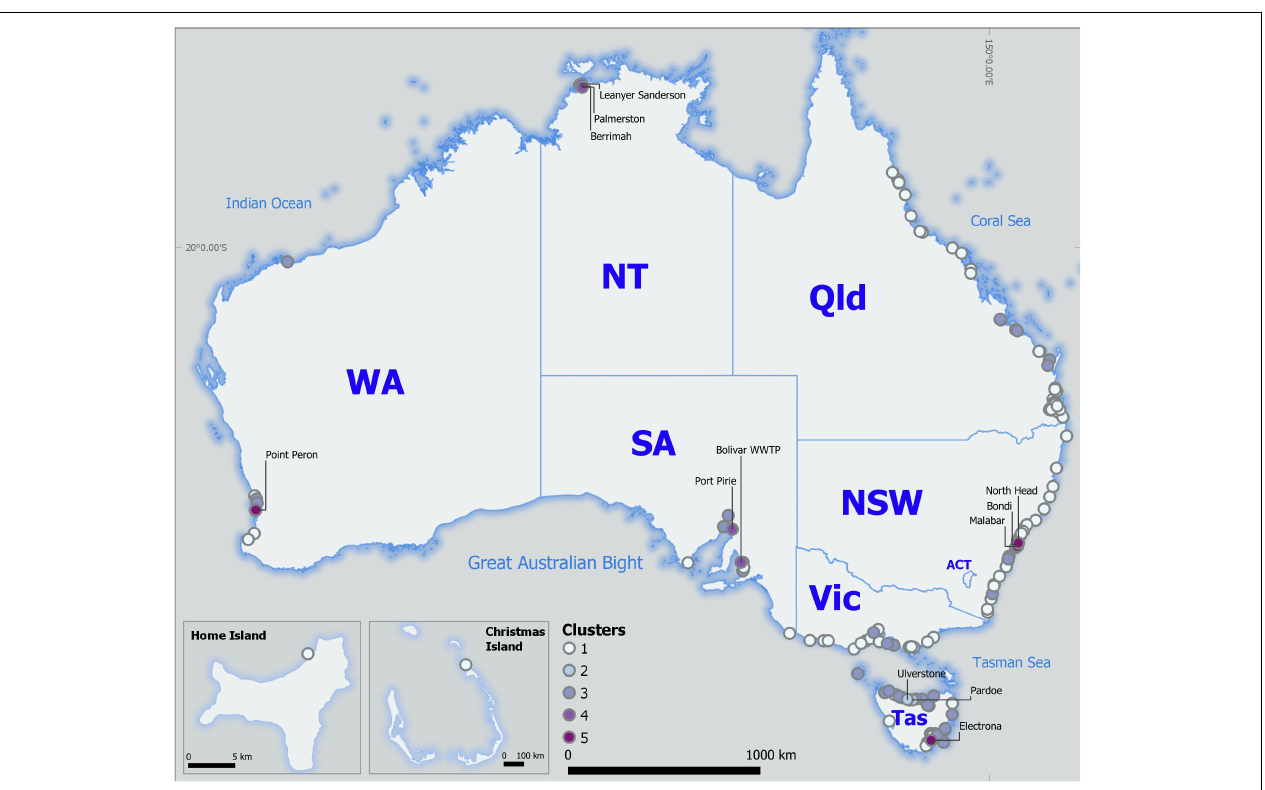
FIGURE 5 | Cluster distribution of Australian coastal outfalls.